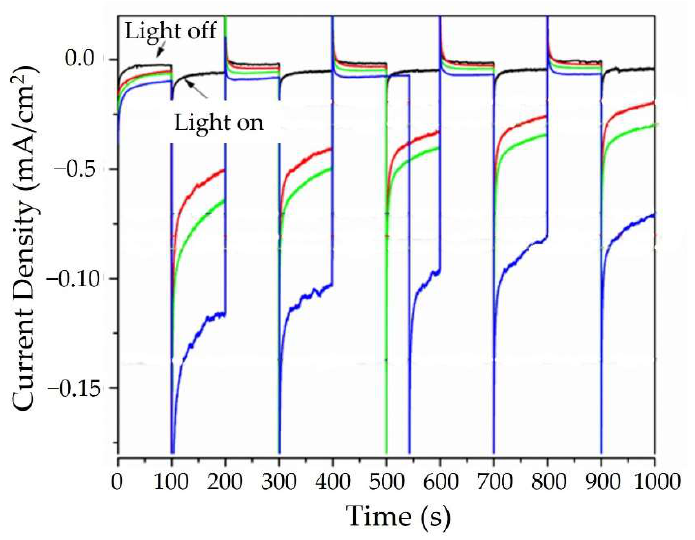
Figure 5. Chronoamperometry ( − 0.25 V applied bias versus SCE) in aqueous 0.5 M Na 2 SO 4 solution at pH ~ 6.3 under chopped visible light irradiation for Cu 3 Ta 7 O 19 films annealed in a vacuum at 500 ◦ C (black), and after heating in air for 20 min at 350 ◦ C (red), 450 ◦ C (green), and at 550 ◦ C (blue). The oxidation of Cu(I) to Cu(II), occurring both at the surface and in the bulk, yielded much higher photocurrents for the Cu (3 − x) Ta 7 O 19 films. This result is surprising given the high concentration of Cu-site vacancies, of up to 50%, that formed when heating in air at 450 to 550 ◦ C. Prior work on Cu(I)-containing semiconductors has shown that the phase segregation of CuO at the surface can result in a favorable band-energy offset to drive more efficient charge separation, such as in Cu (3 − x) VO 4 and CuBi 2 O 4 [6,21]. For p-type Cu 3 Ta 7 O 19 , its band edge energies were determined from Mott–Schottky measurements that yielded a flat band potential of +0.36 V (versus SCE at pH = 6.3). This gave band edge energies of − 1.57 V and +0.73 V for the conduction and valence band edges, respectively. The conduction band edge is therefore located at a significantly more negative